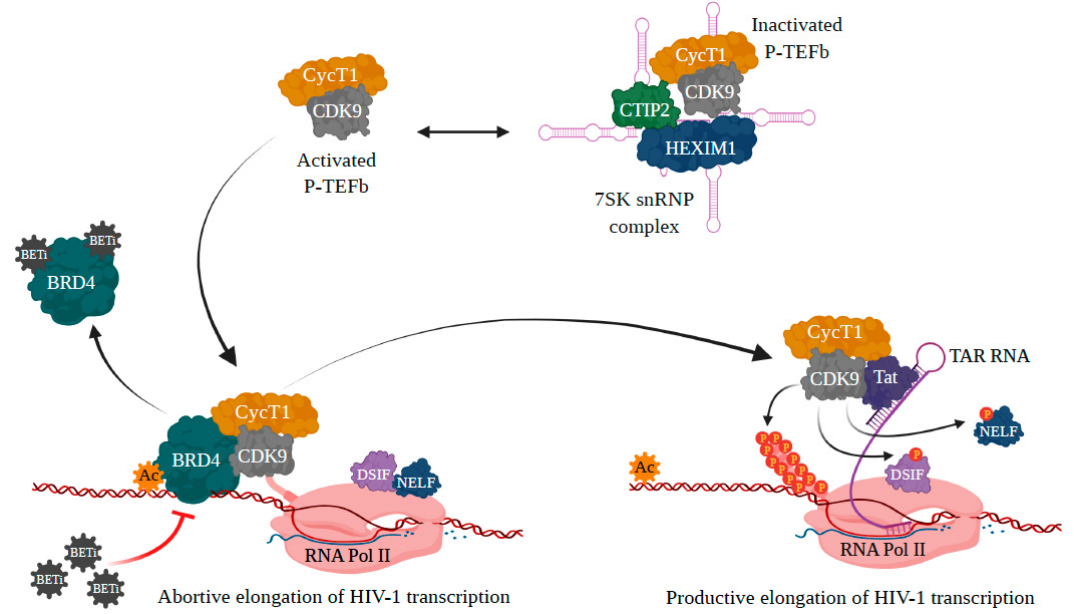
Figure 2. Roles of BET proteins and BETis in HIV-1 latency through the Tat-dependent manner. The 7SK snRNP forming complex which contains HEXIM1 and CTIP2 inactivates P-TEFb (CDK9 and CylinT1). During the cell activation, P-TEFb is released from the complex and becomes an active form that is the target for the viral Tat protein and BRD4. In HIV-1 latency, BRD4 competes with the viral Tat protein for recruiting active P-TEFb, leading to the low productive HIV-1 transcription. Thus, BRD4 inhibition by BETis increases the viral transcription via the phosphorylation of negative elongation factors (DSIF and NELF) and the serine 2 in CTD of RNA Pol II by the viral Tat/P-TEFb complex. The figure was created with BioRender.com.